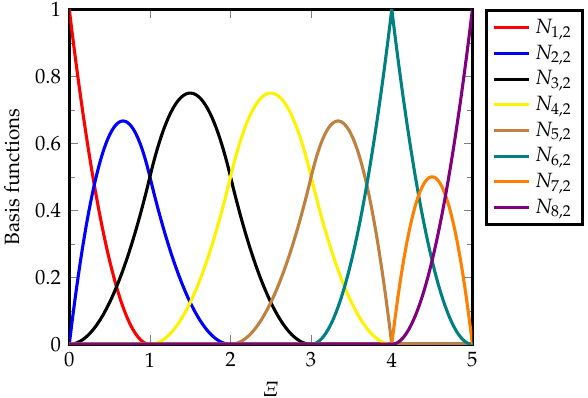
Figure 2. Non-uniform rational B-splines, order of the curve, p =